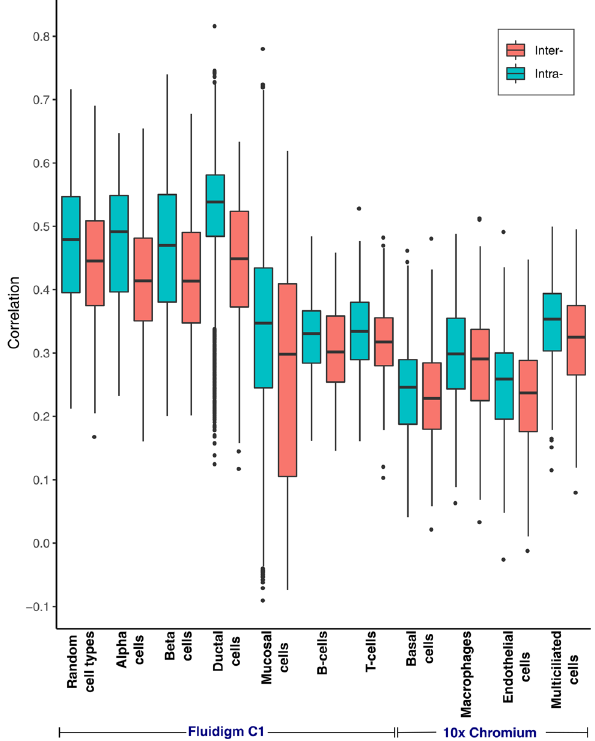
Fig. 1 Intra-individual correlation. Intra- and inter-individual Spearman ’ s correlations for gene expression values across ten different pancreatic cell types and a random sample of different cell types. The respective numbers of cells and individuals used for each cell type are listed in the Methods section. Median correlation among a donor ’ s own cells (intra- individual) is always greater than the mean correlation across individuals (inter-individual). The “ random cell types ” boxplots represent a random sampling of alpha, beta, and ductal cells. The center line represents the median. The lower and upper box limits represent the 25% and 75% quantiles, respectively. The whiskers extend to the largest observation within the box limit ±1.5 × interquartile range. n = 40,775 cells from 43 different individuals over four independent experiments. More details about each experiment are provided in